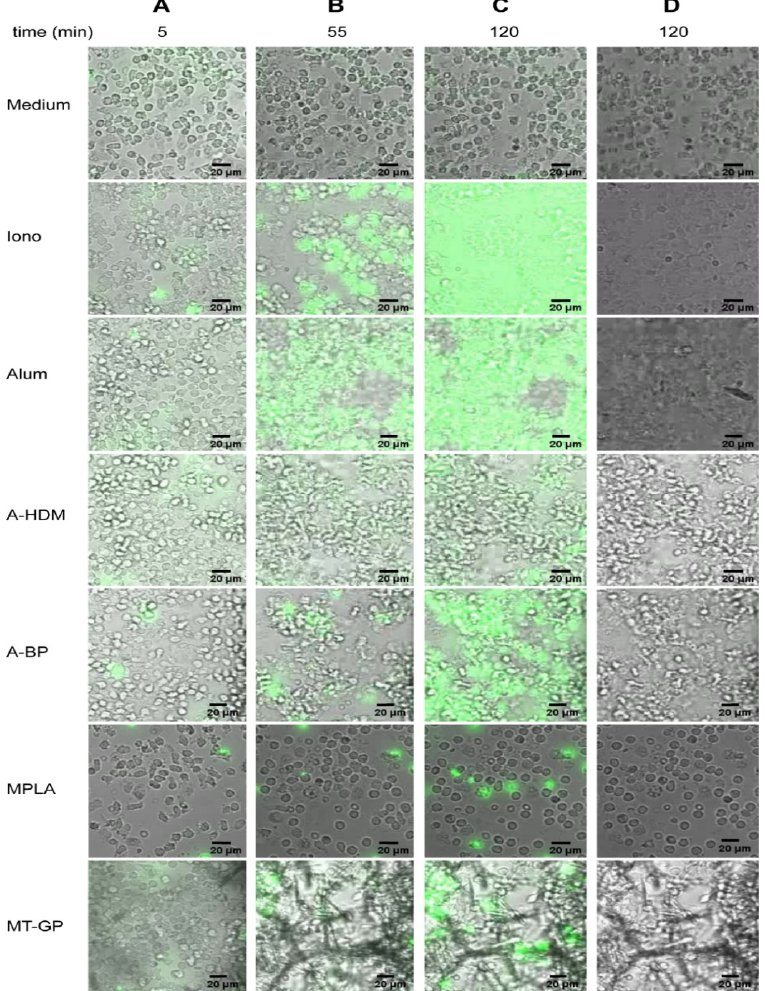
Figure 1. Time lapse imaging of neutrophil extracellular trap (NET) release. Freshly isolated human neutrophils were primed with 25 ng/mL of GM-CSF and incubated for 2 h with medium, ionomycin (Iono; 5 µ M), alum (100 µ g/mL), the alum containing vaccines A-HDM (89 µ g alum/mL) and A- BP (100 µ g alum/mL), and further monophosphoryl-lipid A (MPLA; (5 µ g/mL) and the vaccine containing MPLA and L-tyrosine microcrystals (represented by the needle-like structures): MT-GP (2 µ g MPLA/mL) in the presence of Sytox green. Shown images were acquired via wide field microscopy at indicated time points ( A – D ) with merged channels showing DNA staining (green) ( A – C ) compared to bright field alone ( D ). HDM, house dust mite extract; BP, birch pollen extract; GP, grass pollen extract. (Scale bars, 20 µ